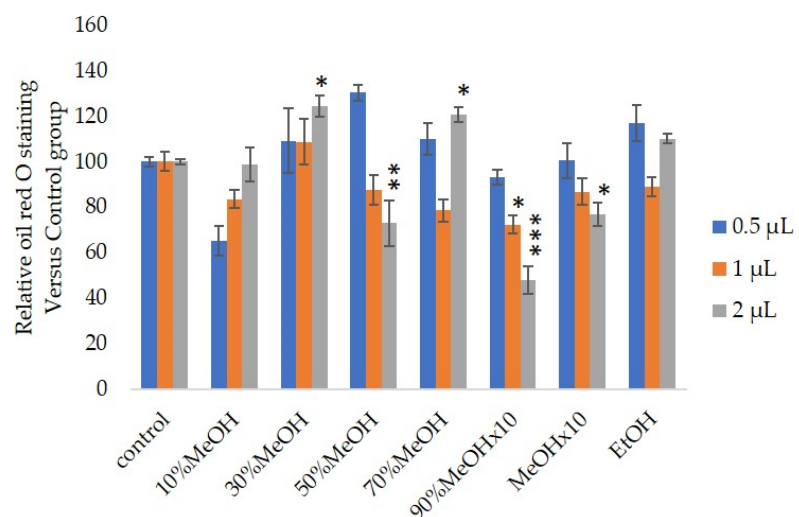
Figure 1. Effects of Sep-PaktC18 fractions on 3T3-L1 cell differentiation. We assessed the abilities of 10%MeOH, 30%MeOH, 50%MeOH, 70%MeOH and EtOH fractions at the concentration of 10 mg/mL in ethanol and 90%MeOH and MeOH fractions at the concentration of 1 mg/mL in ethanol to inhibit 3T3-L1 cell differentiation. Values are shown as means ± SD ( n = 4). * p < 0.05, ** p < 0.01 and *** p < 0.001 vs. control (ANOVA with post hoc Dunnett tests).